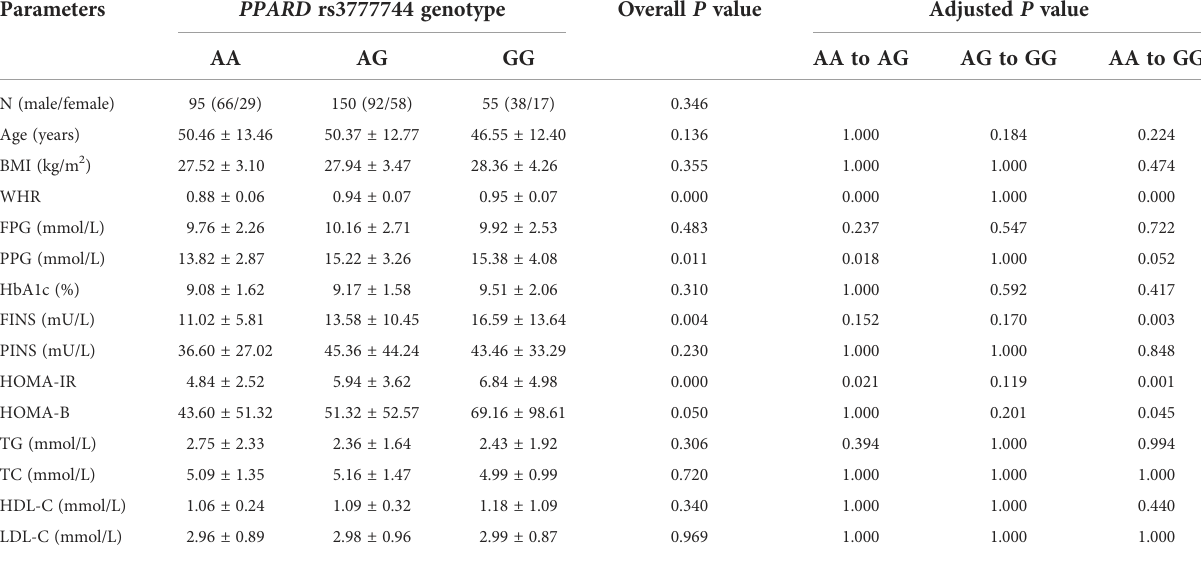
TABLE 3 The baseline characteristics in type 2 diabetes mellitus (T2DM) patients with various PPARD rs3777744 genotypes before treatment with exenatide (n=300).